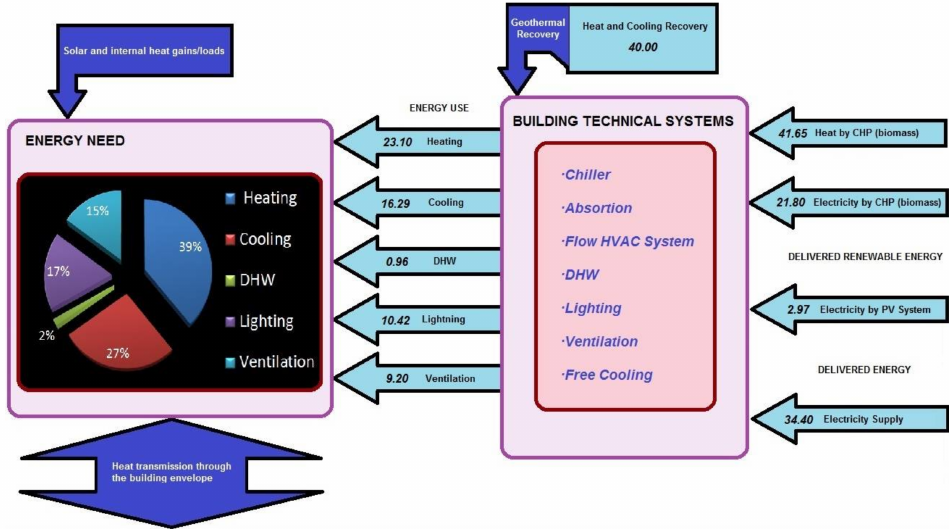
Figure 16. Energy Balance LUCIA nZEB per year and m 2